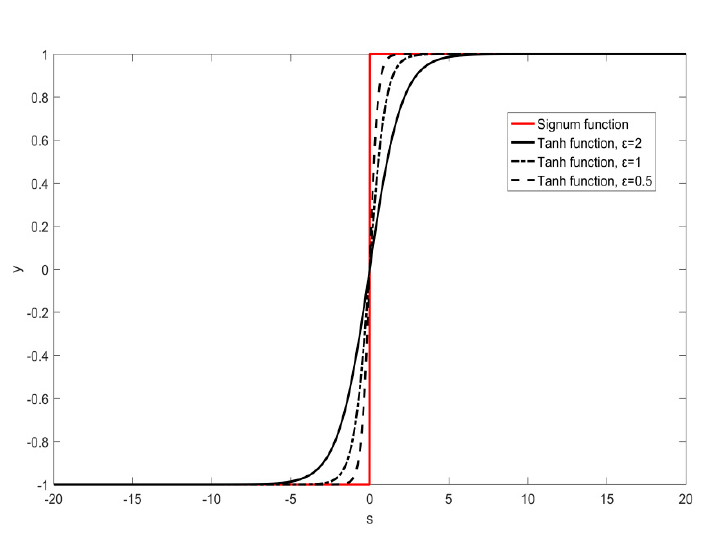
Figure 1. the tanh function with several different 𝜀 .